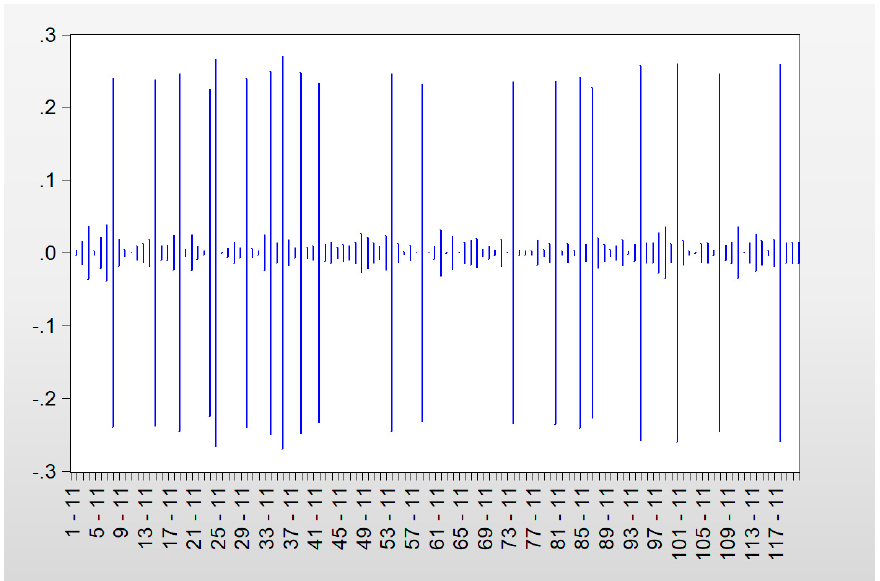
Figure 4. The influence of competitiveness and voting rights of major shareholders on the quality of corporate boards after the COVID-19 pandemic. Source: Author’s computations.